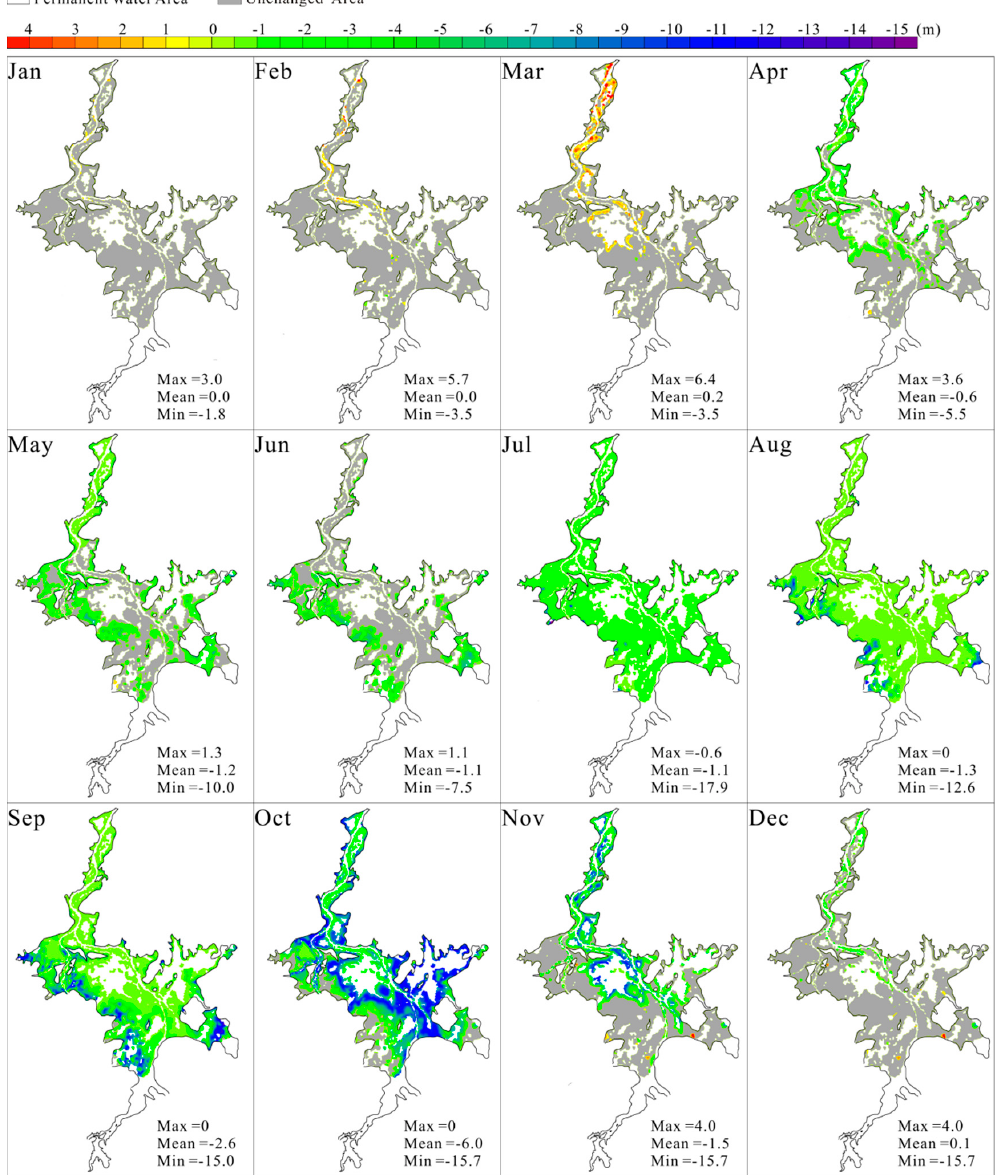
Figure 3. Spatial differences and varying degree of monthly average lake levels in the Poyang Lake floodplains between S1 and S2 (S1–S2). The gray area indicates the unaffected floodplains.